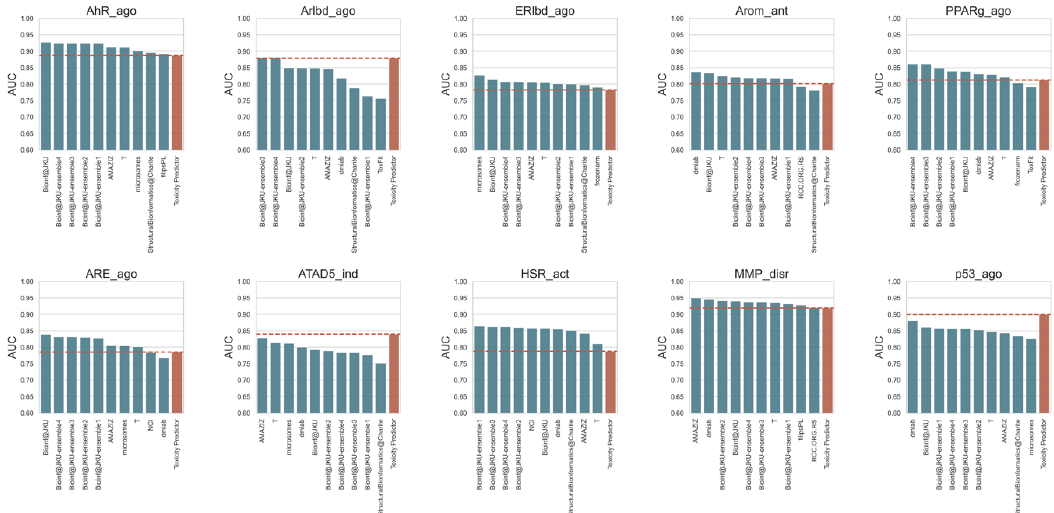
Figure 4. Comparison of the Toxicity Predictor models with the Tox21 Data Challenge 2014 models: This figure shows the predictive performance of the top 10 Tox21 Data Challenge and Toxicity Predictor models, which were built for 10 toxicity targets (AhR_ago, Arlbd_ago, ERlbd_ago, Arom_ant, PPARg_ago, ARE_ago, ATAD_ind, HSR_act, MMP_disr, and p53_ago). The horizontal axis denotes the names of the modeling teams of the Tox21 Data Challenge, and the vertical axis indicates the areas under the curve (AUCs).